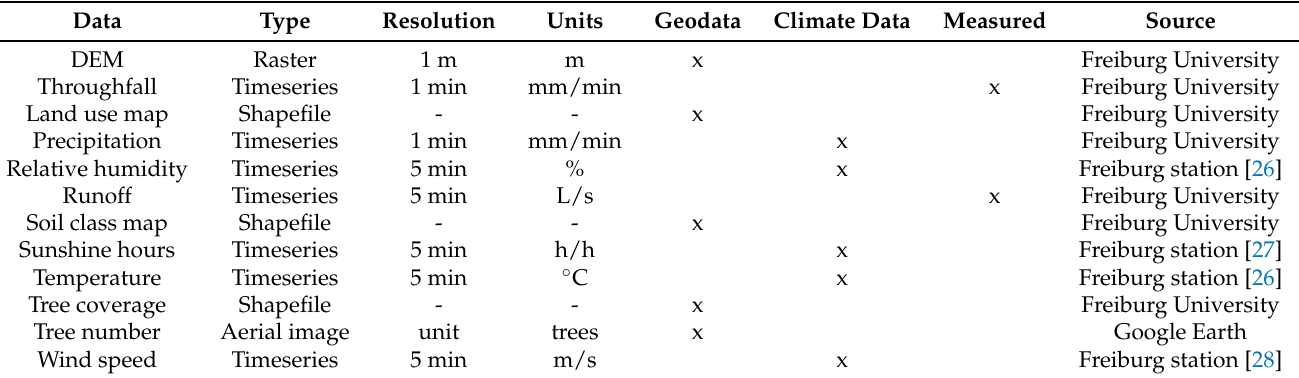
Table 1. Overview of the input datasets for the LEAFlood